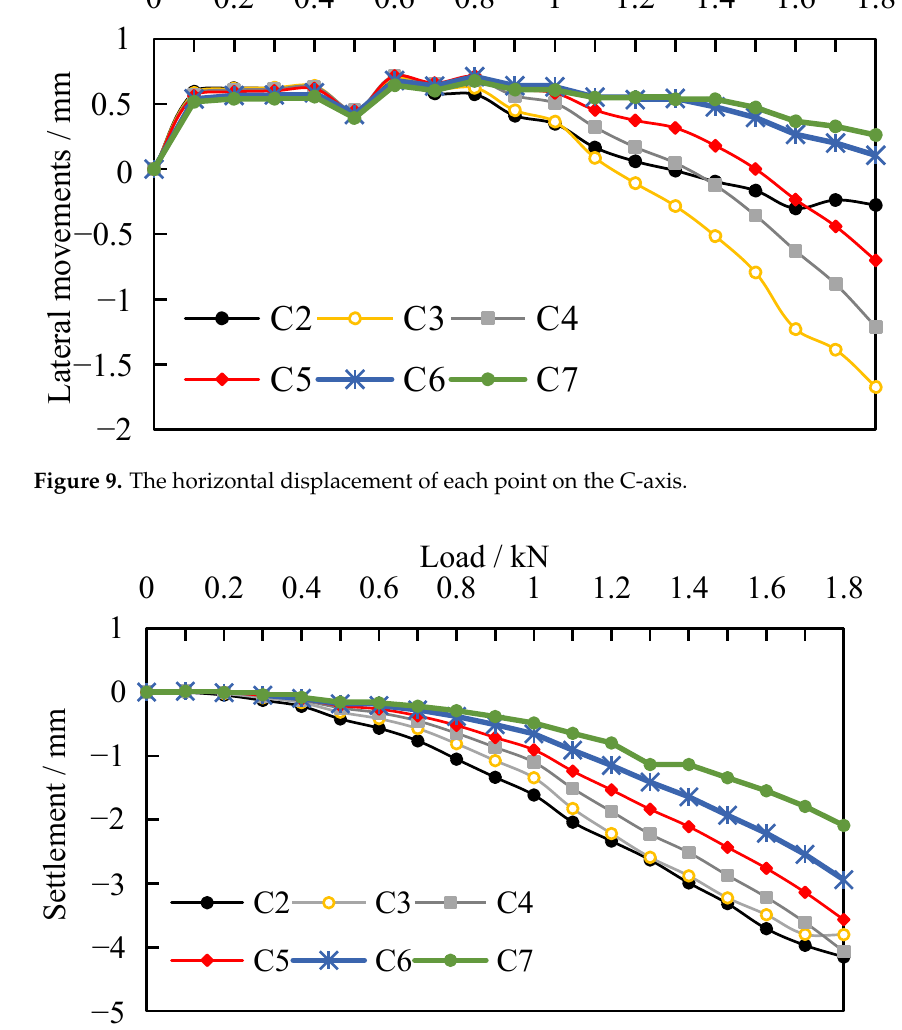
Figure 10. The vertical displacement of each point on the C-axis.